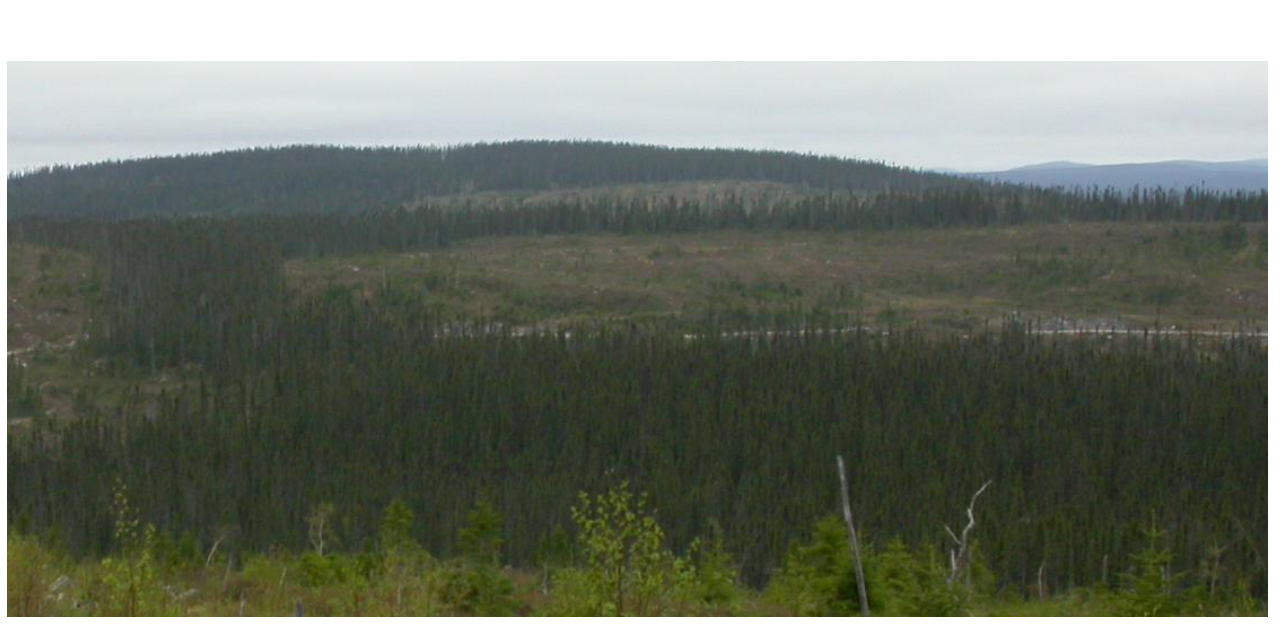
Fig. 2. Example of interspersed landscape of logged and residual forested blocks after the first pass of the mosaic harvesting regime in the study